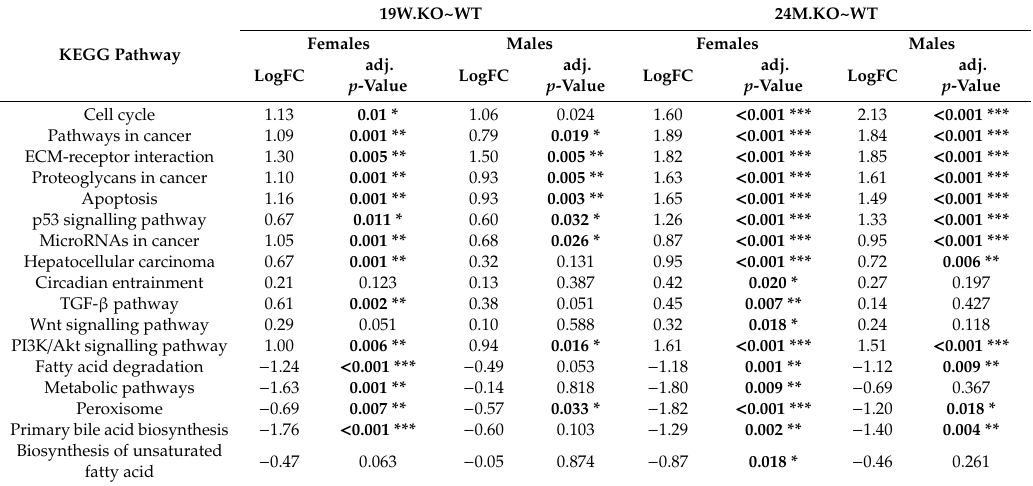
Table 1. The most significantly enriched KEGG pathways in 19W KO (19W.KO~WT) and 24M KO (24M.KO~WT) mice. Parameters shown in bold are statistically significant. KEGG, Kyoto Encyclopaedia of Genes and Genomes; * p < 0.05, ** p < 0.01, *** p < 0.001.